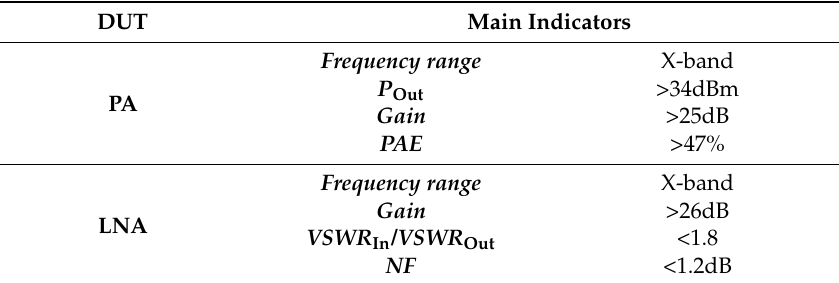
Table 6. DUTs’ main indicators for